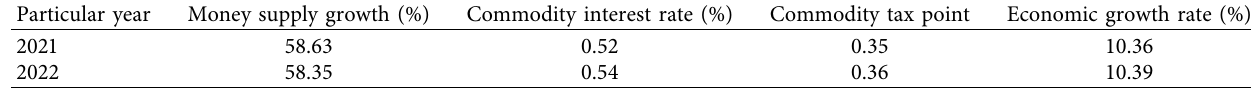
Table 5: Money supply growth rate and economic growth rate in the past two years.